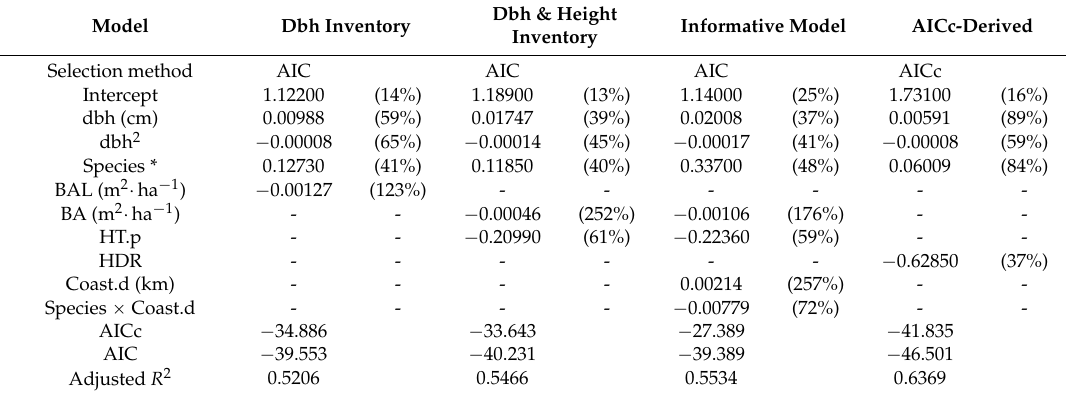
Table 2. BIX branch model coefficients (s.e. as percent of coefficient in parentheses) for Mendocino County,